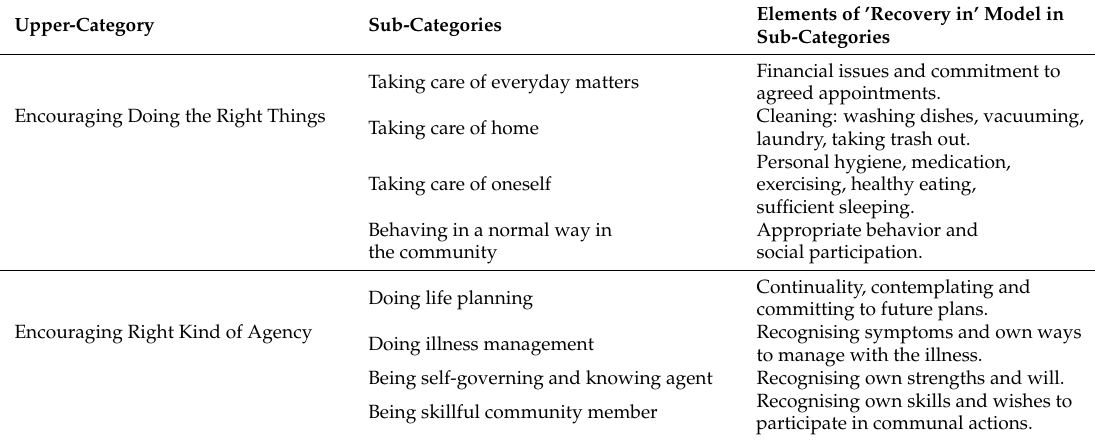
Table 1. Elements of “recovery in”